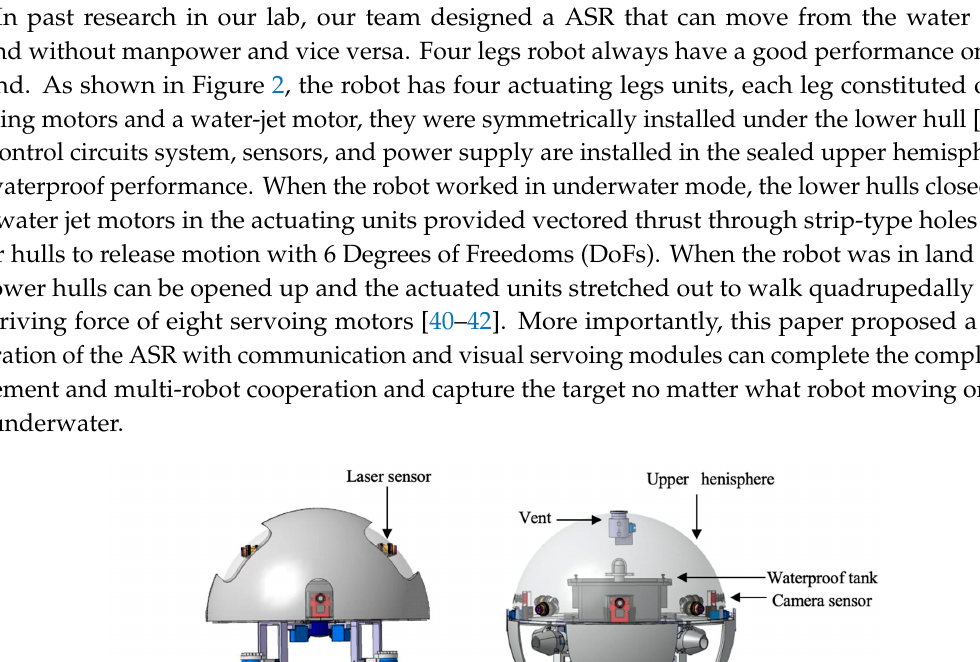
Figure 1. Schematic of the multi-robot cooperation (this study uses ( a ) mode: n = 3). ( a ) Leader cooperation model; ( b ) Decentralized cooperation model.